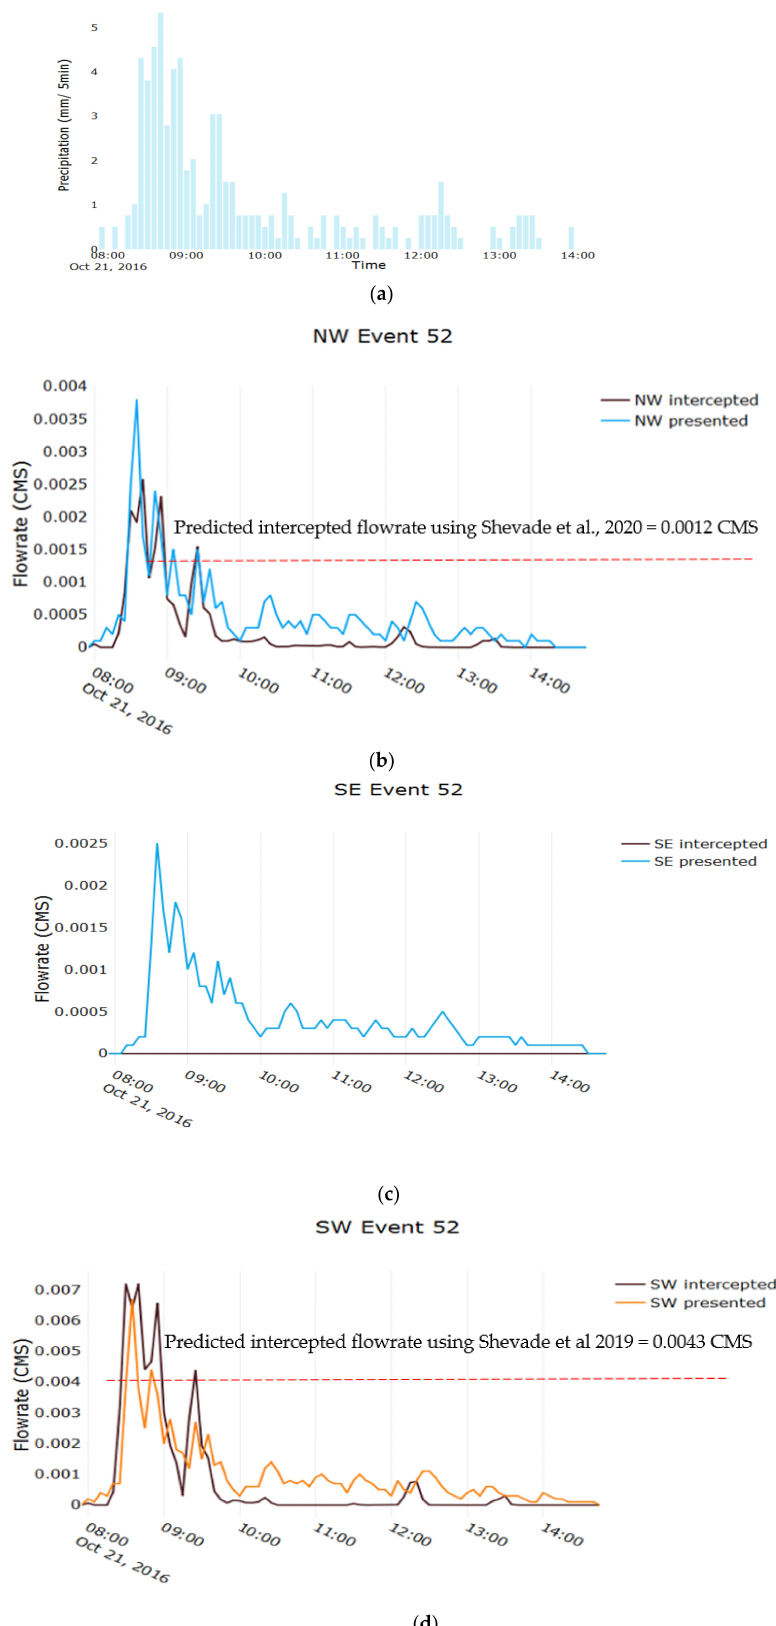
Figure 7. ( a ) Precipitation recorded at site and ( b – d ) comparisons of observed inflow (intercepted by inlet) flowrate and estimated presented inflow flowrate over the tributary catchment areas for respective inlets at the Happyland site (inlets NW, SE, and SW) during Event